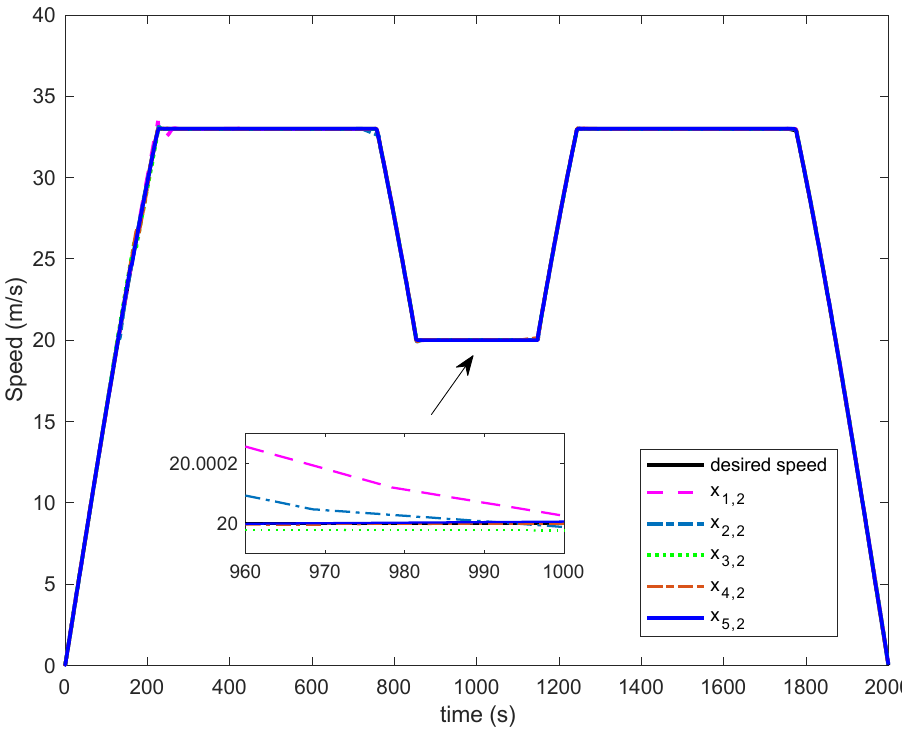
Figure 4. Desired speed and speed tracking performance of each train.